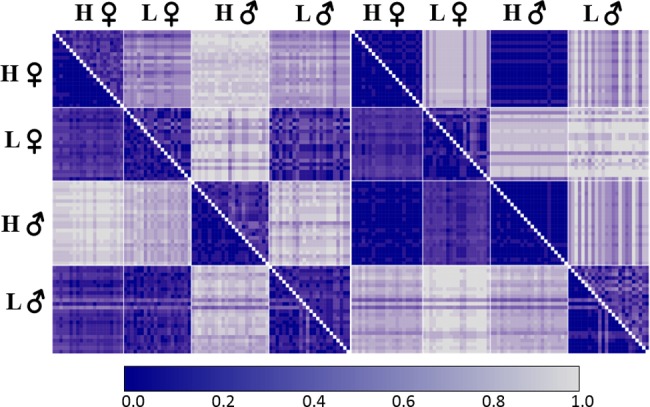
—Hamming’s proportional distance among Niveoscincus ocellatus individuals of highland (H) and lowland (L) populations for sex-linked loci unique to the highland (left panel) and lowland (right panel) populations. Presence/absence (PA; lower segment) and SNP (upper segment). Highland PA n = 16, lowland PA n = 20, highland SNPs n = 12, lowland SNPs n = 16.